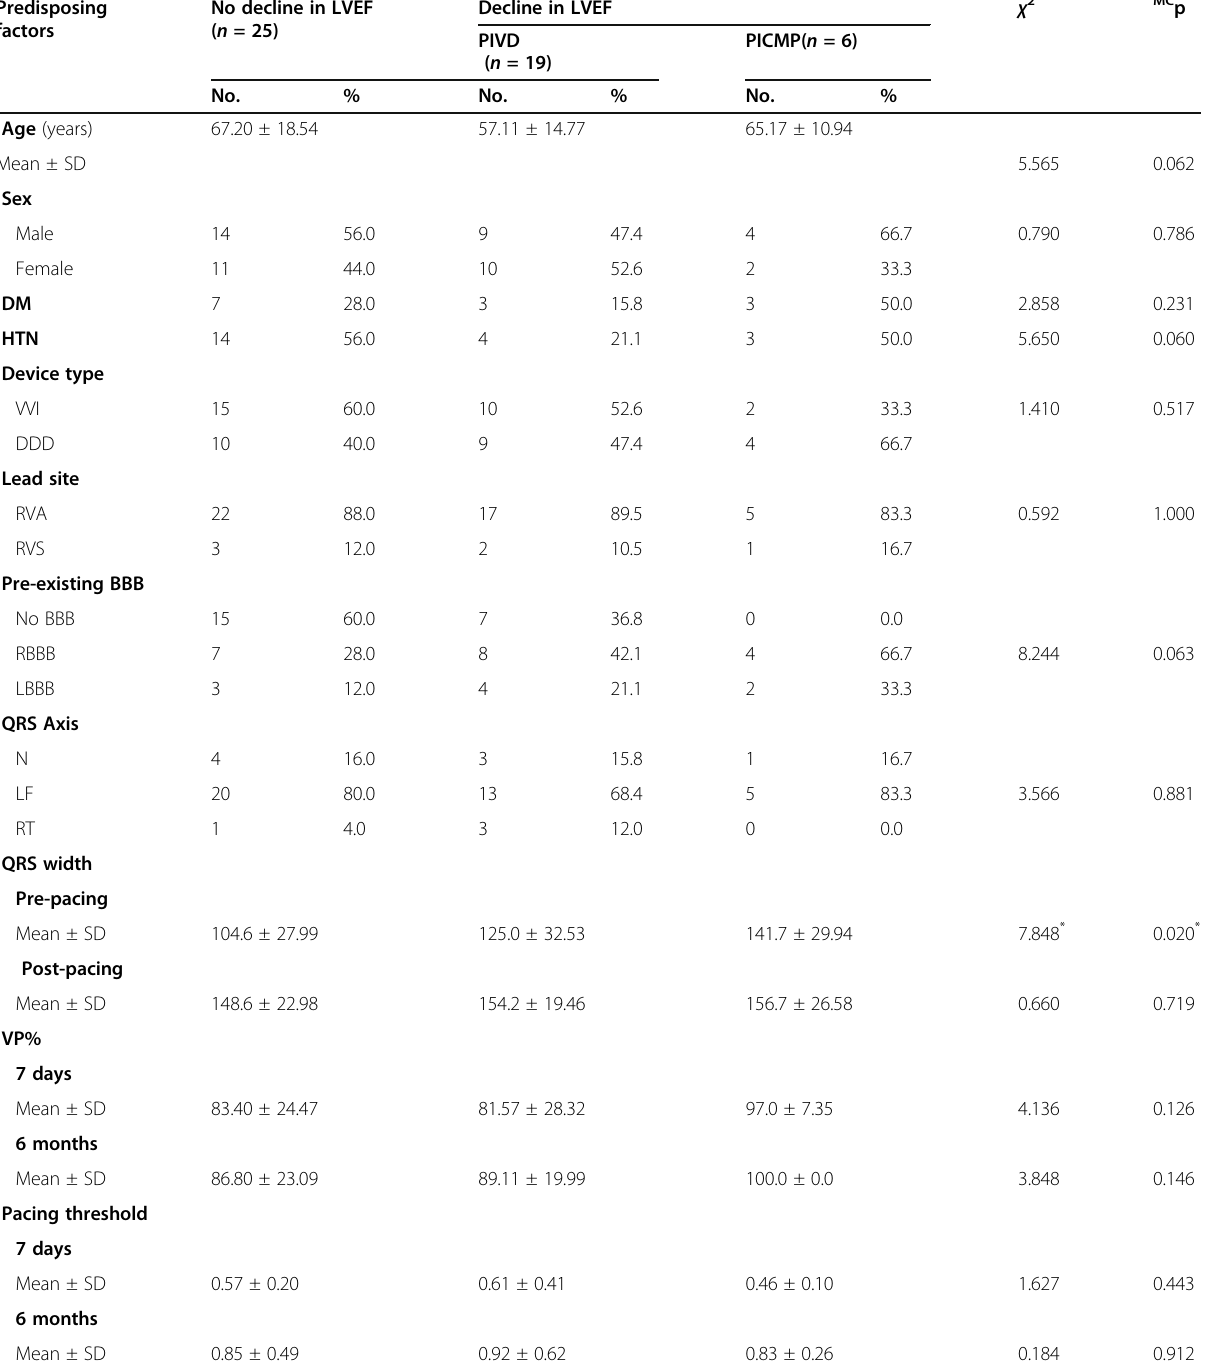
Table 4 Comparison between the three studied groups according to risk factors Predisposing